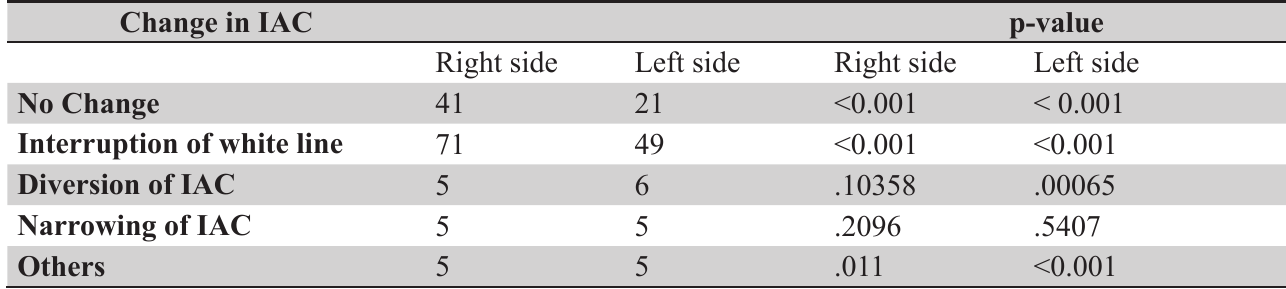
Table 2b. Darkening of roots of mandibular third molar on right and left side of mandible with respect to change in IAC seen on the same side.